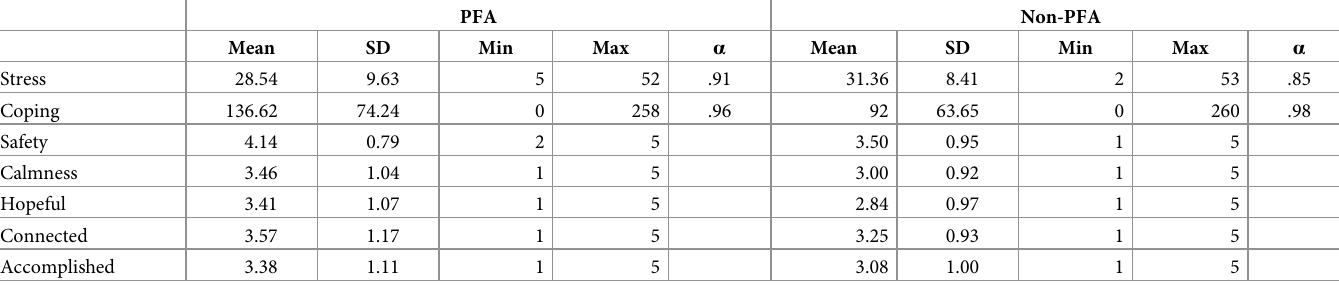
Table 3. Phase 1 descriptive